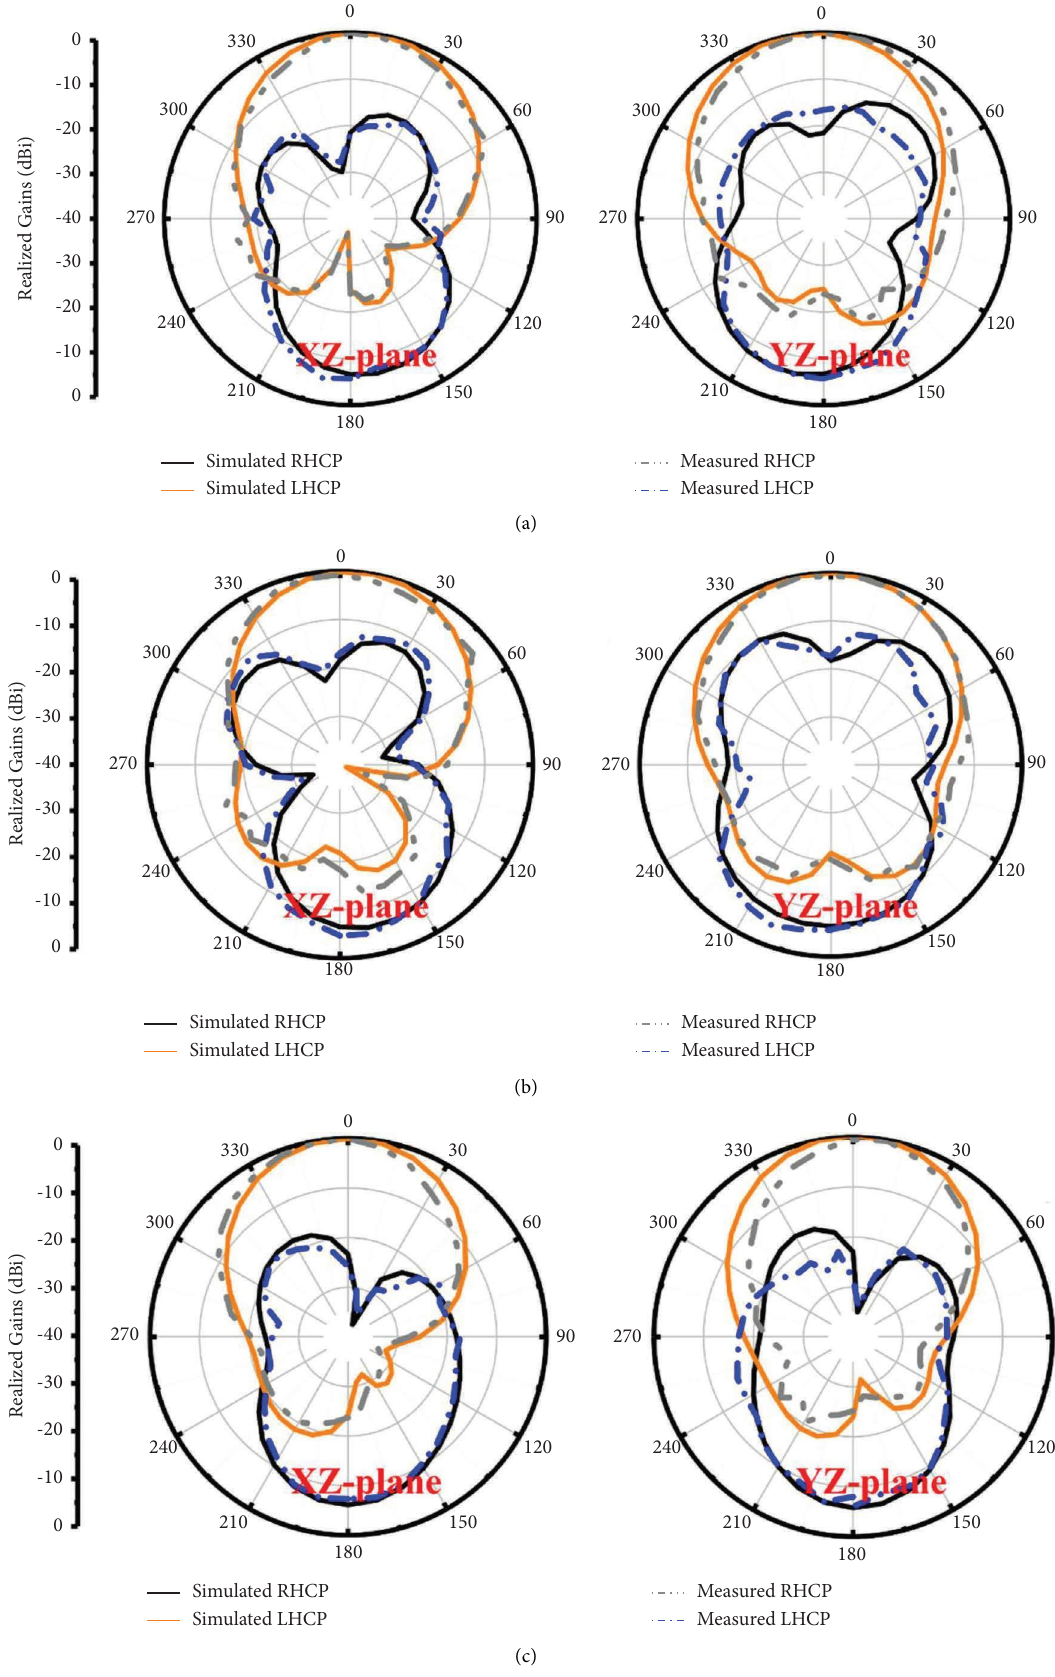
Figure 8: Simulated and measured normalized radiation patterns of the CP MPA at (a) 5.35, (b) 5.80, and (c)